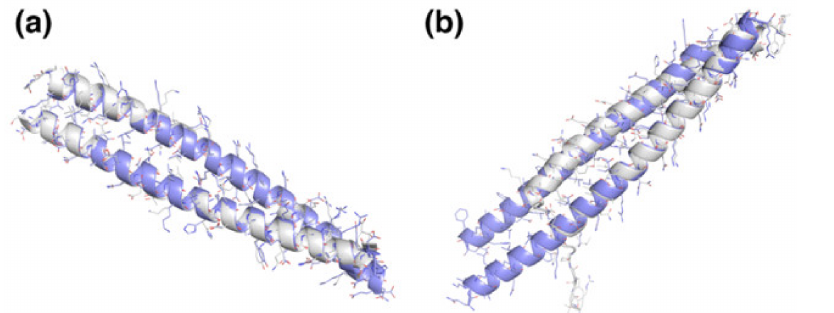
Figure 2. In two cases of modelled coiled coils (purple) there are experimentally solved crystal struc- tures (gray). ( a ) SYNZIP1:SYNZIP2 the lowest energy model fully recovered the crystal structure. ( b ) SYNZIP5:SYNZIP6 frameshifted in one of the coiled coils at the formed interface. Nevertheless, both folded energy landscapes indicate a well-formed folding funnel towards the lowest energy model.